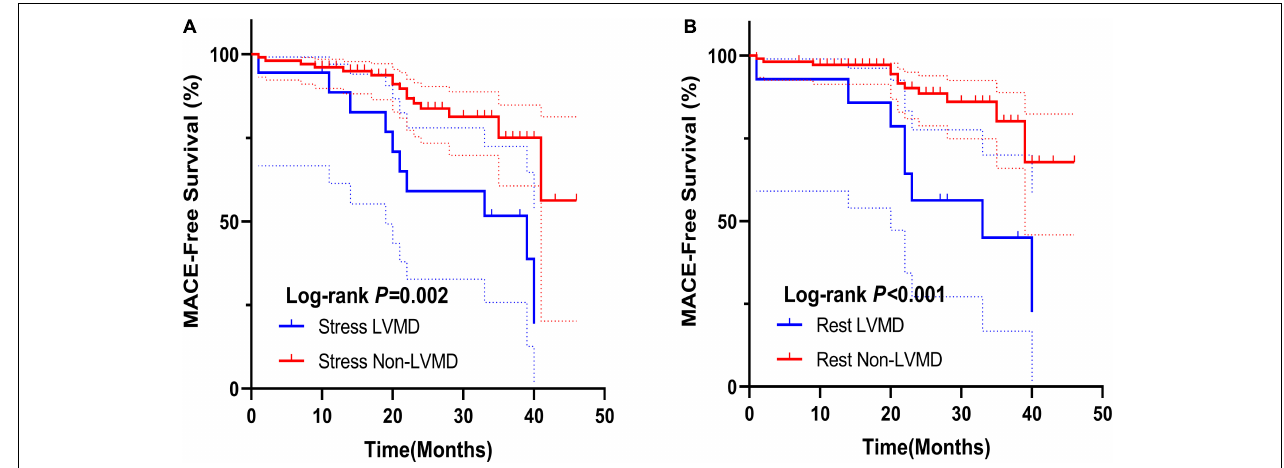
FIGURE 3 | (A) Kaplan–Meier curves for MACEs according to stress LVMD. (B) Kaplan–Meier curves for MACEs according to rest LVMD.